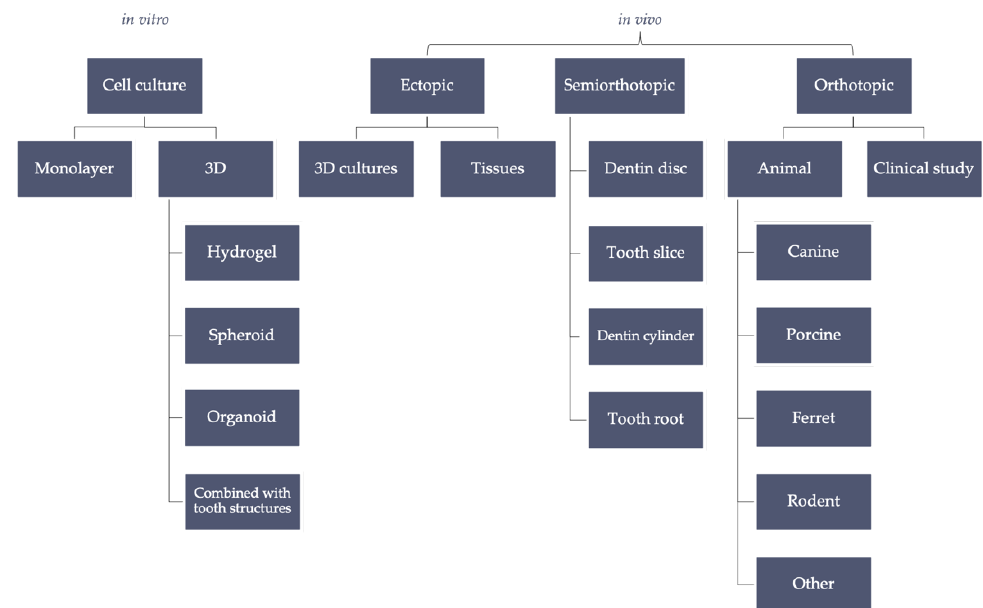
Figure 1. Compilation of study models for dental pulp tissue